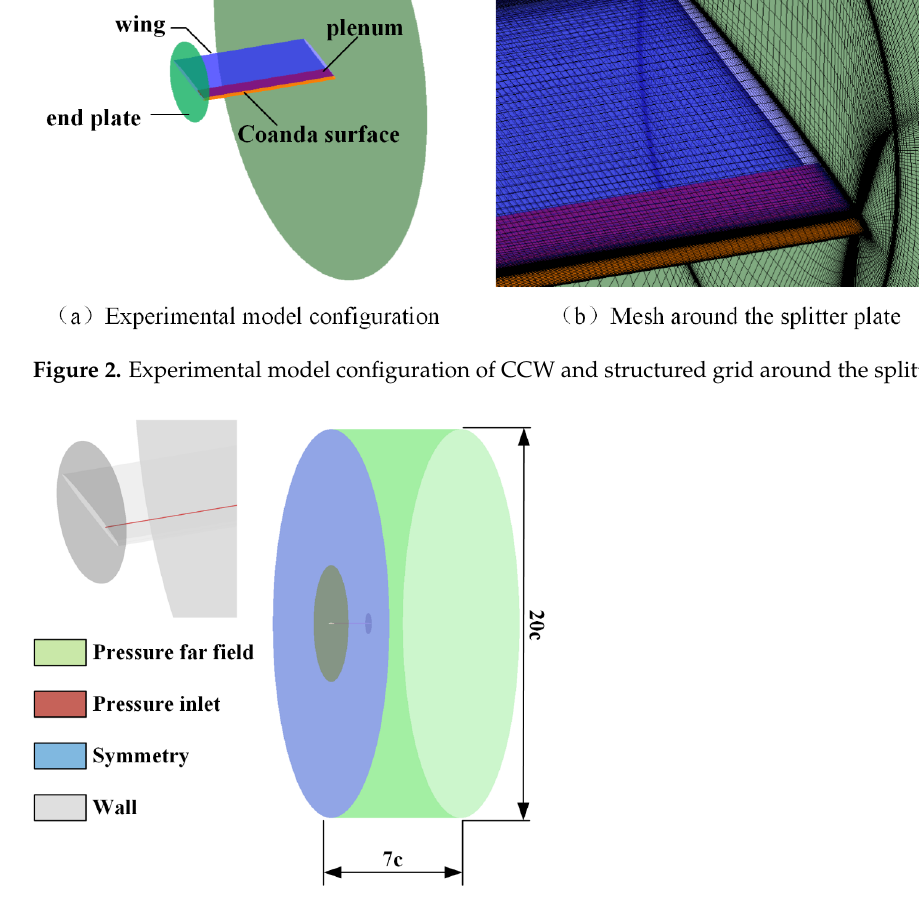
Figure 3. Computational domain of